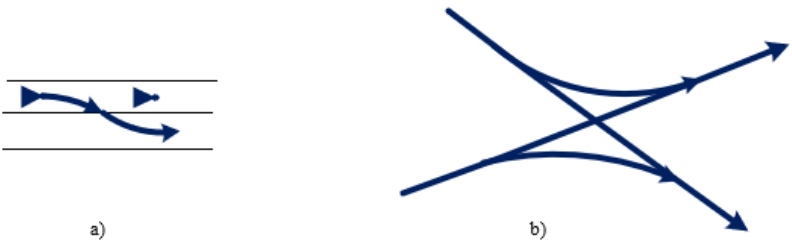
Figure 12. Crossing: ( a ) changing lane, ( b ) changing heading (in top view). However, changing the direction (or heading) is not as straightforward. To minimize the number of potential conflicts, lanes of different headings are at different altitudes. Thus, heading modifications lead to the following six simple maneuvers, as shown in Figure 13.